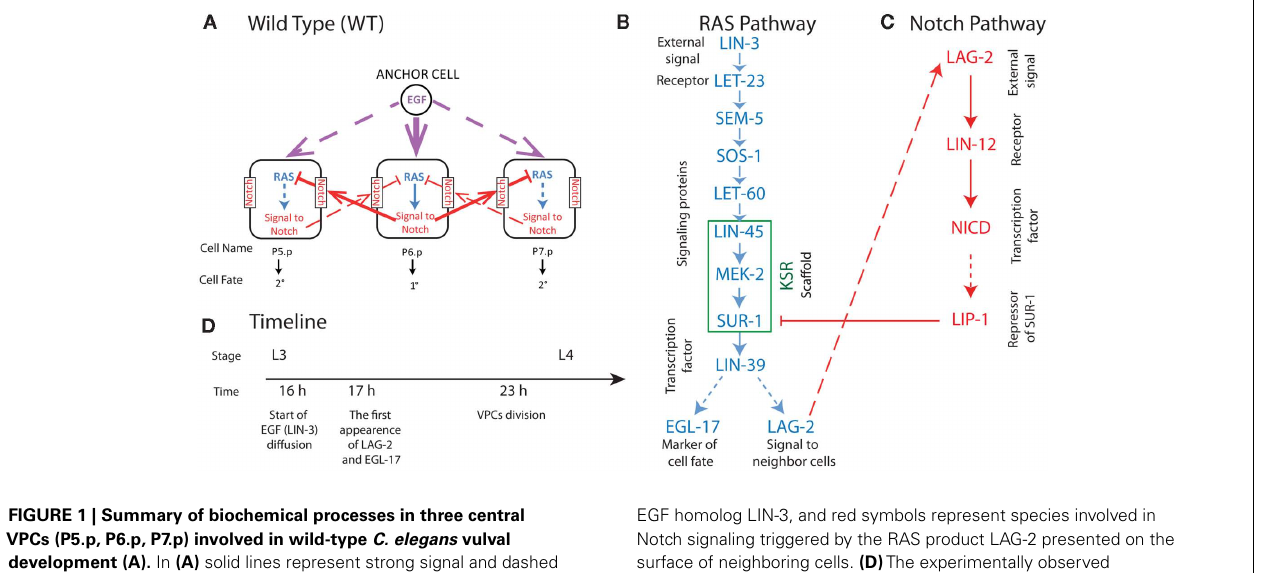
FIGURE 1 | Summary of biochemical processes in three central VPCs (P5.p, P6.p, P7.p) involved in wild-type C. elegans vulval development (A). In (A) solid lines represent strong signal and dashed lines weak signal in wild-typeVPC development. In (B,C) solid arrows represent cell signaling processes and dashed arrows creation of species by transcription and translation. Blue symbols represent species involved in the C. elegans RAS signaling triggered by the